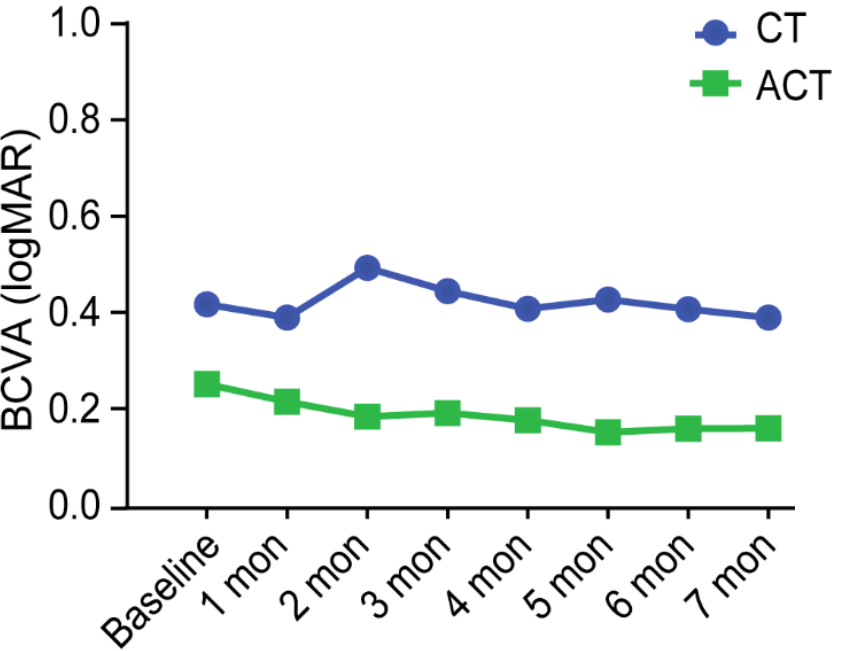
Figure 4. Variation in BCVA (LogMAR) per eye in the ACT (adalimumab plus conventional therapy) group and in the CT (conventional therapy) group during treatment.